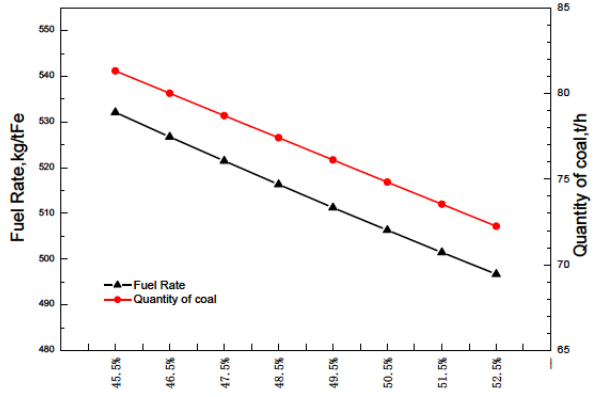
Figure 1: Estimated fuel rate and quantity of coal needed on differ- ent η CO